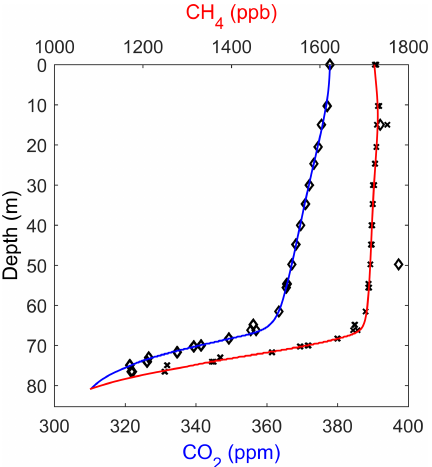
Figure 6. Simulated and observed CO 2 and CH 4 concentrations in the firn at WAIS Divide. The model is initialized with the recorded atmospheric trace gas concentrations in 1800CE at all depths and is forced at the surface with histories of atmospheric CO 2 and CH 4 concentrations (Etheridge et al., 1996, 1998; Keeling et al., 2005; Buizert et al., 2012; Dlugokencky et al., 2016a, b). Markers indicate observed CO 2 (diamonds) and CH 4 (crosses) concentrations (Battle et al., 2011). Based on high CO 2 and CH 4 , two samples at ∼ 15 and ∼ 50m depth were likely compromised by modern air during analysis and are thus ignored in the curve fit. Differences in the CO 2 and CH 4 profiles between the 1-D model and the 2-D model with or without barometric pumping are not visible at the resolution of this figure but are illustrated in Fig.